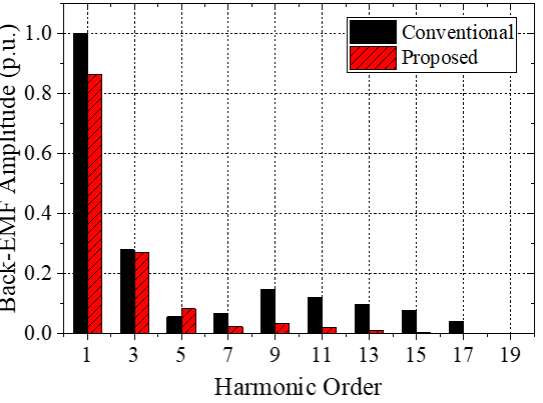
Figure 9. Comparison of normalized back-EMF space harmonic distribution profile of the conven- tional and proposed motor.